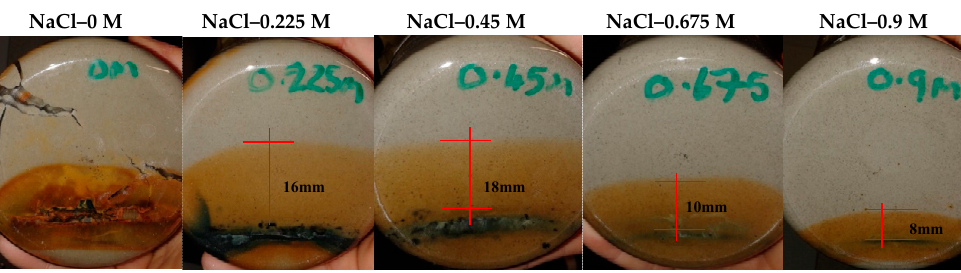
Figure 9. Swell index results for batch #2 (dotted line indicates the control free swell value).